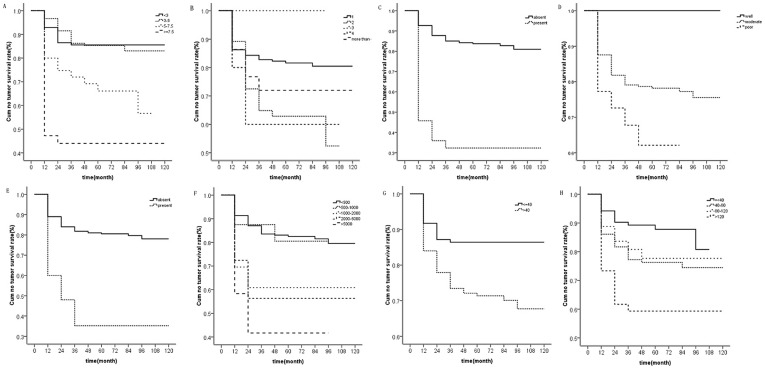
Univariate analysis of factors affecting of tumor recurrence-free survival rates of HCC patients in the study: (A) tumor size, (B) tumor number, (C) vascular invasion, (D) tumor differentiation, (E) lymph node invasion, (F) pre-LT serum AFP level, (G) pre-LT Serum ALT levels, and (H) pre-LT Serum AST levels.